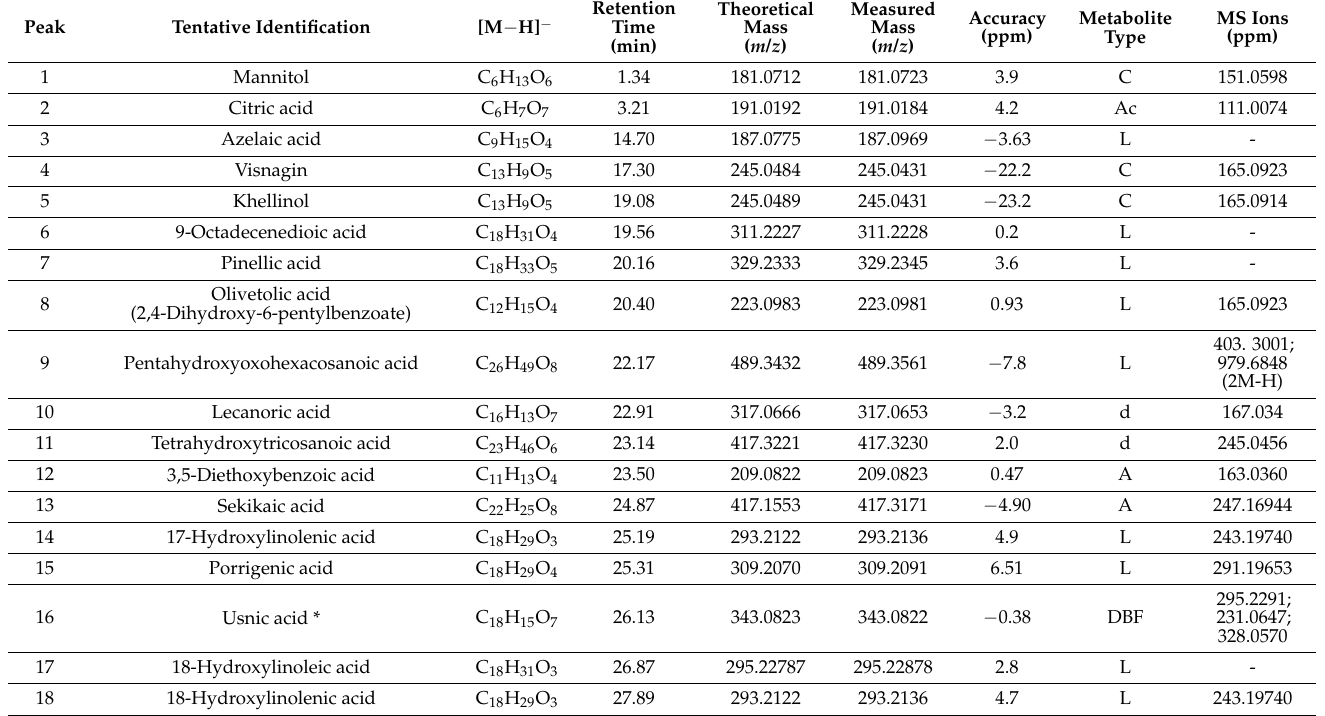
Table 2. Identification of metabolites in Pseudephebe pubescens by